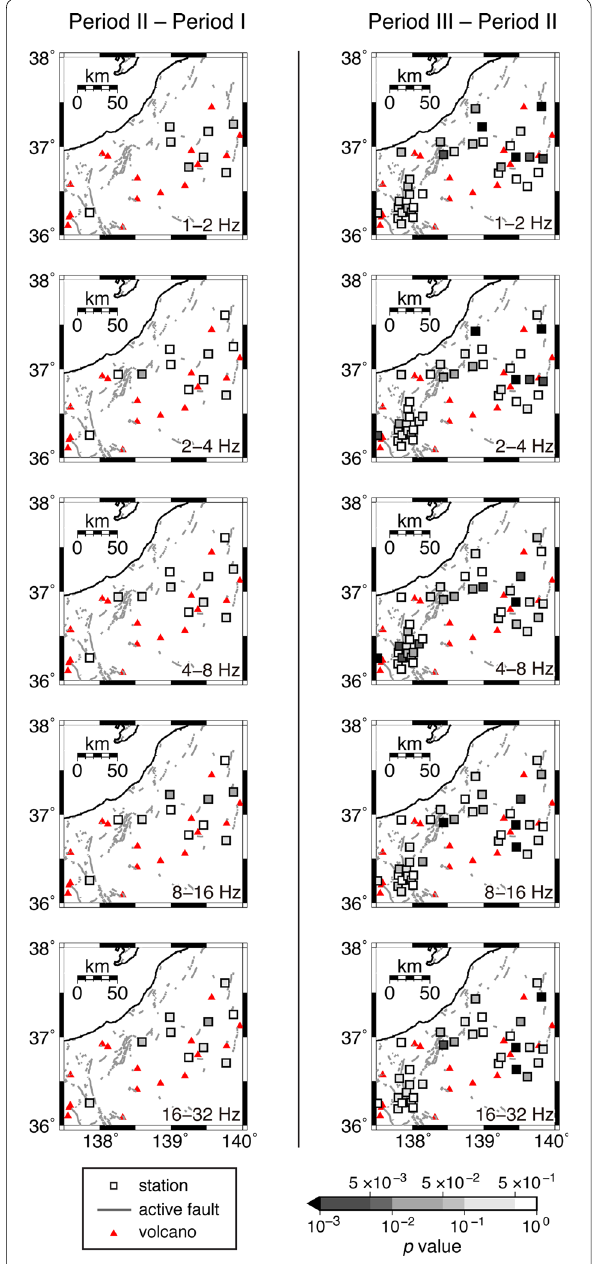
Fig. 6 Spatial distributions of the p value for the difference of the mean of log 10 Q C − 1 for the successive two periods at each frequency band; left panels between the period II and the period I, and right panels between the period III (Dojo and Hiramatsu 2017) and the period II. Gray scale shows the p the differential strain rates and the perturbation of the S-wave velocity at each depth at 0.2° 0.2° and calculate × the correlation coefficient and p value between the two quantities.